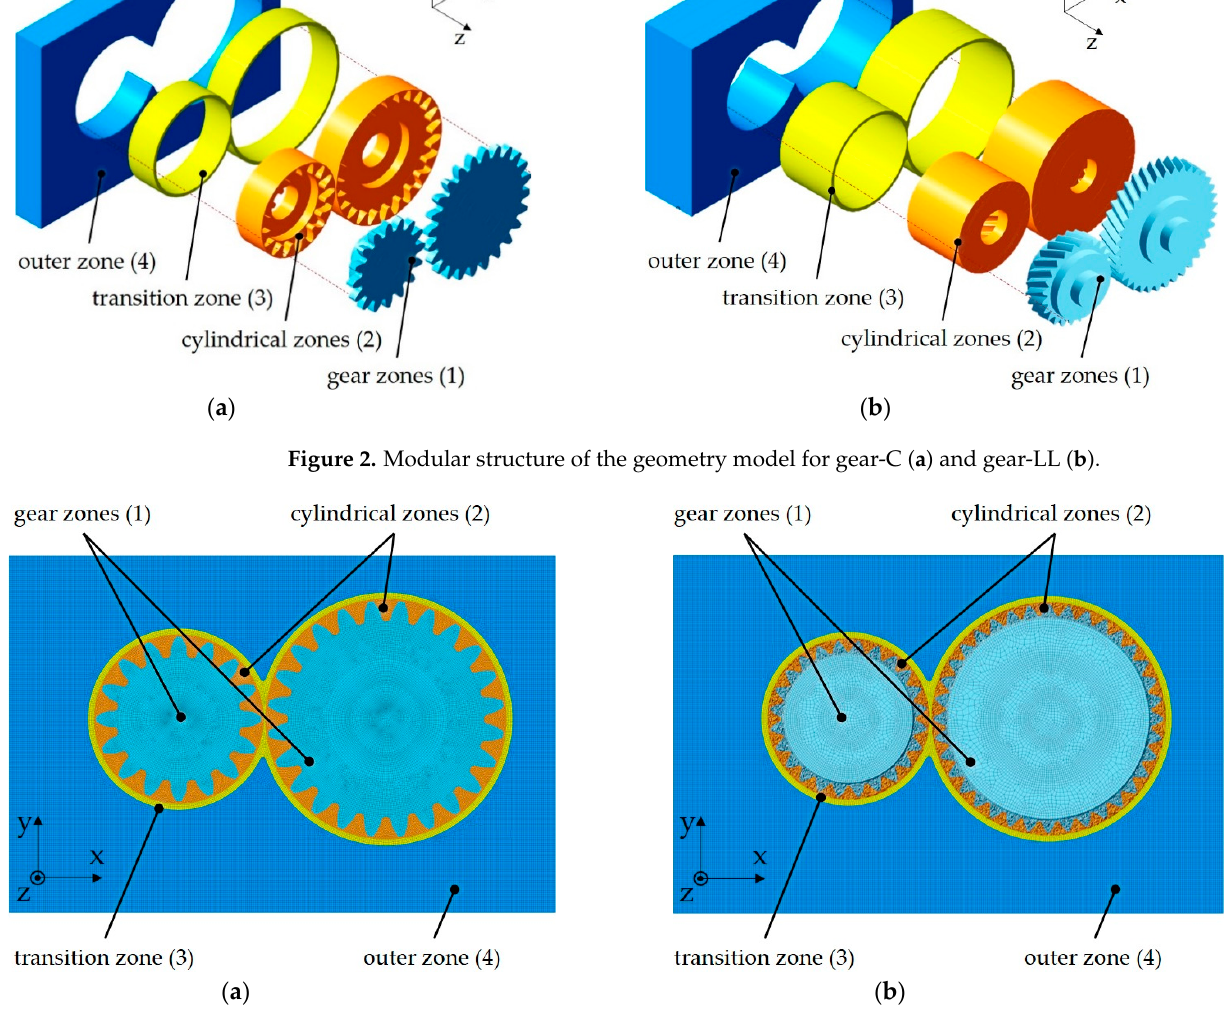
Figure 3. Front view on the mesh model Mesh gear-C ( a ) and Mesh gear-LL ( b ). Table 3. Properties of the considered mesh models Mesh gear-C and Mesh gear-LL (prism.: prismatic; hex.: hexahedral; tet.: